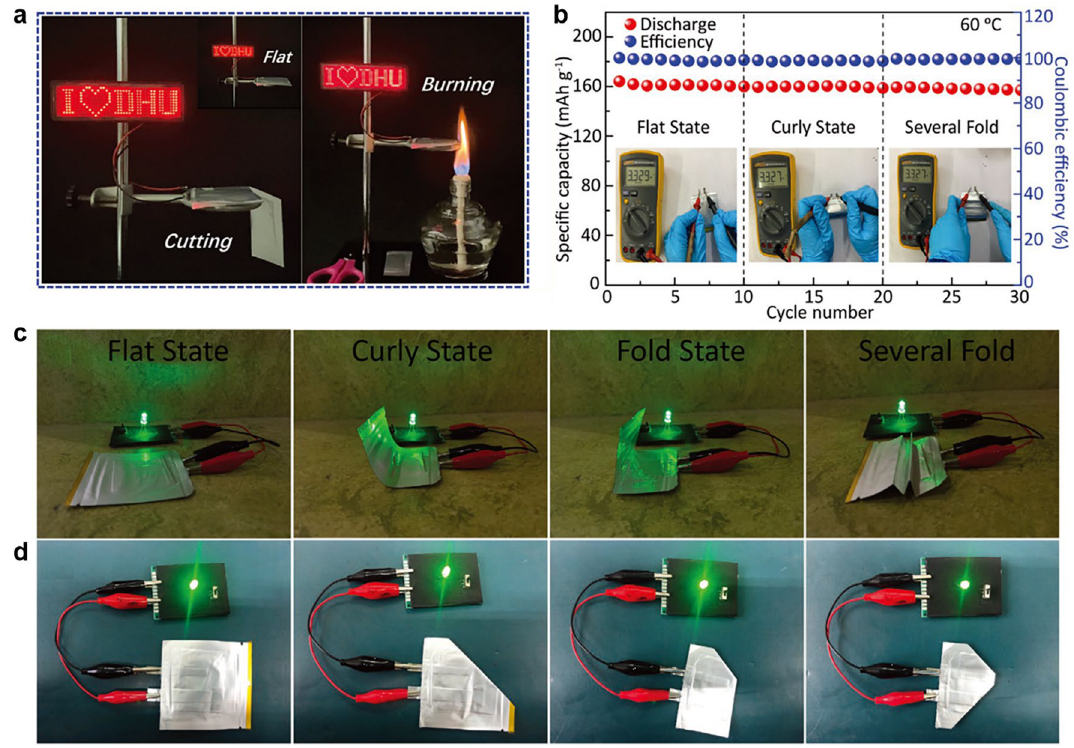
Fig. 13 a Test of LCO//Li pouch cell by lighting a LED under cutting and burning. Reproduced with permission [196]. Copyright 2020, Wiley– VCH. b Cyclic performance of LFP//Li pouch cell under different states at 0.1C, the insets are the voltage variation images of the pouch cell before and after curling and folding. c Optical photographs of the flexible LFP//Li pouch cell under different states, lighting up an LED in series. d Safety evaluation of LFP//Li pouch cell under extreme conditions. b – d Reproduced with permission [135]. Copyright 2021,